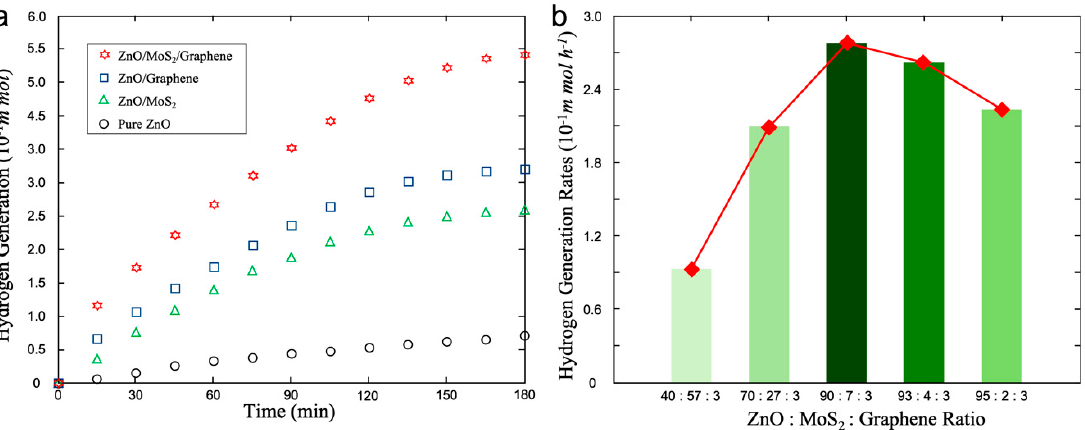
Figure 5. Photocatalytic e ffi ciency measurements. ( a ) Diagram of hydrogen generation rates of ZnO, ZnO / graphene, ZnO / MoS 2 , and ZnO / MoS 2 / graphene catalysts; ( b ) hydrogen generation rates diagram of various componential ZnO / MoS 2 / graphene photocatalysts.